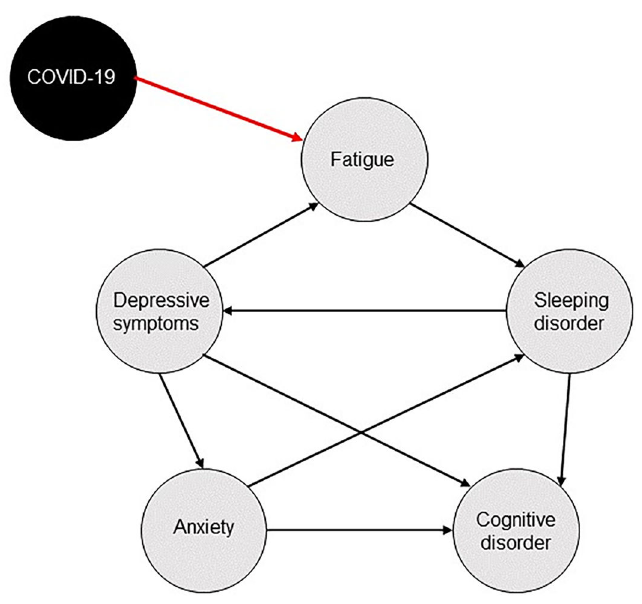
Note. Acute COVID-19 infection in the external field (black node) initially activates symptoms, e.g., fatigue, that spread the activation to other symptoms in the network (grey